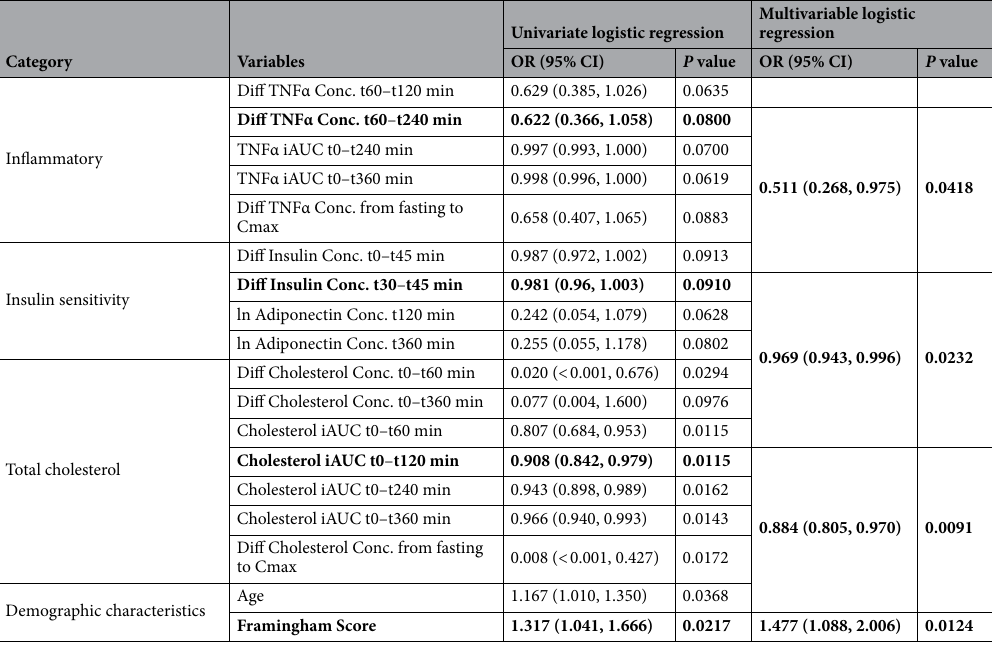
Table 4. Potential candidate predictors of subclinical atherosclerosis in males (n = 55) assessed using univariable logistic regression. Odds ratios are expressed per standard deviation increase in each continuous risk factor. Highlighted variables are independent risk predictors of subclinical atherosclerosis admitted by stepwise selection into the multivariable logistic regression models. OR, Odds ratio; CI, Confidence interval; TNFa, Tumor necrosis factor alpha; iAUC, incremental area under curve; Cmax, Peak concentration; Other demographic characteristics such as BMI, Diastolic blood pressure, Systolic blood pressure, waist circumference, weight, fasting glucose, fasting LDL-C, fasting HDL-C, fasting Triglyceride, fasting total cholesterol, age and Framingham score were also examined. Variables not listed in table have p > 0.10 in the univariate logistic regression models. Significant values are in